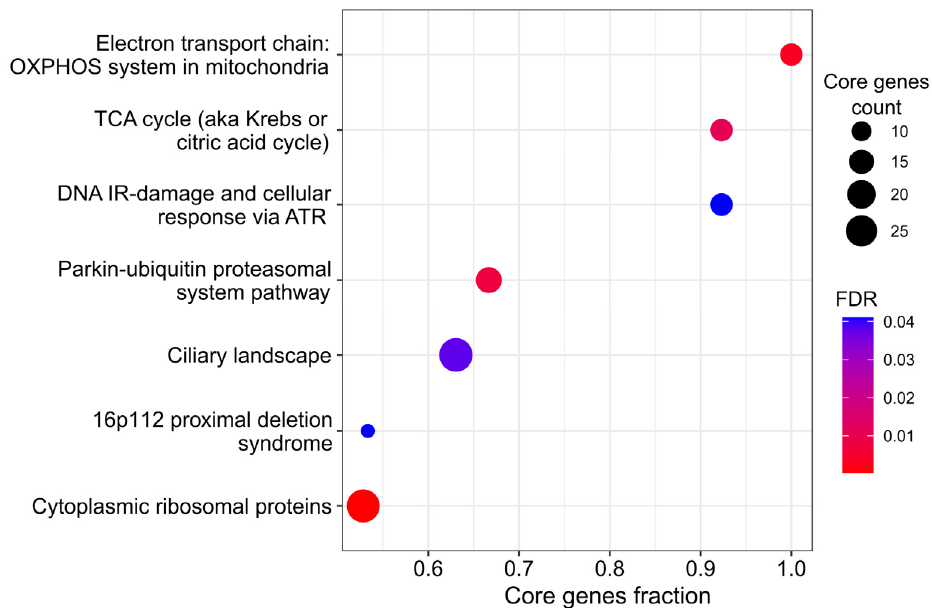
Figure 3. Proteomic profiling of HepG2 WT and TOMM34 KO cells. Gene Set Enrichment Analysis: pathways perturbed in TOMM34 KO cells compared to WT cells. Core genes is the subset of genes in the geneset contributing to the enrichment signal.